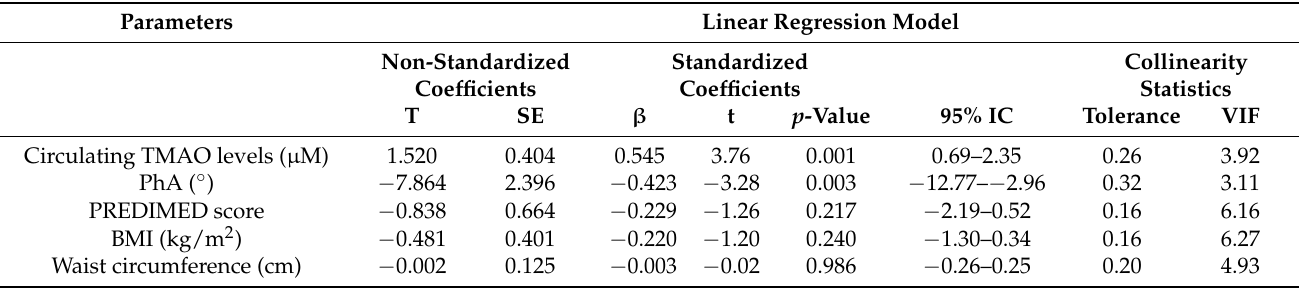
Table 5. Linear regression model of the association between HS Sartorius score (as a dependent variable) and BMI, waist circumference, circulating TMAO levels, PREDIMED score, total energy intake, and PhA as independent